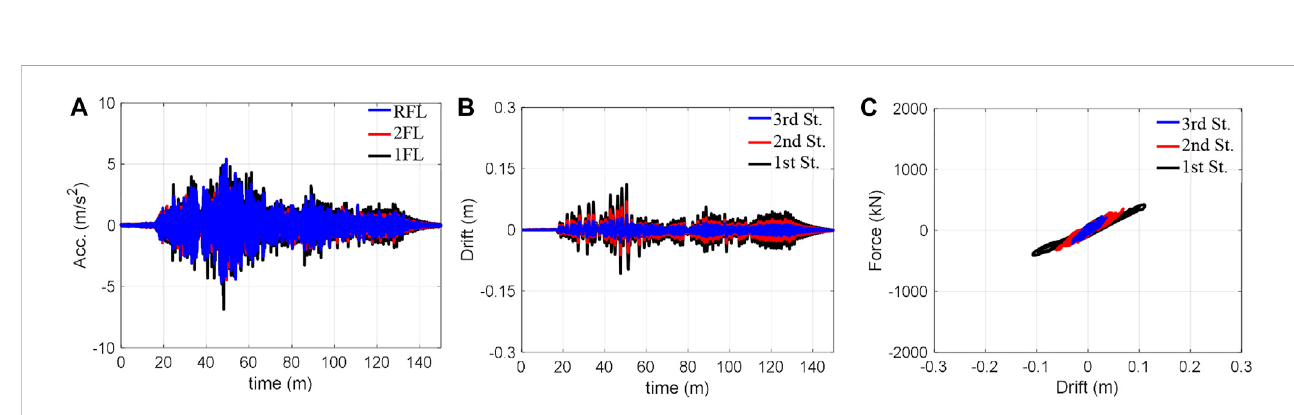
FIGURE 10 Responses of 150% Nankai: (A) acceleration, (B) inter-storey drift, and (C) hysteretic loops.